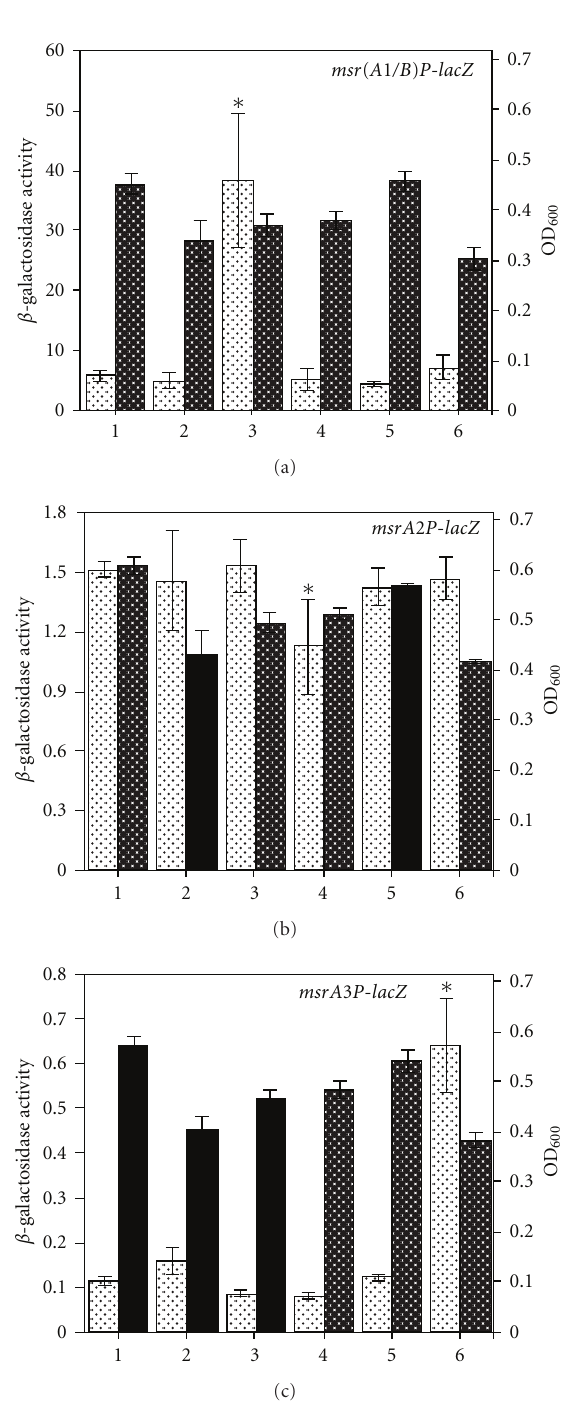
Figure 3: Expression of the msr(A1/B) , msrA2 , and msrA3 loci in S. aureus SH1000 under di ff erent environmental stress conditions. Cultures of S. aureus SH1000 msr(A1/B)P-lacZ , msrA2P-lacZ , and msrA3P-lacZ reporter strains were grown to OD 600 of 0.3 at 37 ◦ C and treated separately with H 2 O 2 (15mM) (2), oxacillin (1.2 μ g/mL) (3), pH 5.0 (4), pH 9.0 (5), and TSB with 1.5 M added NaCl (6) for 1h. β -galactosidase activity ( lighter bar ) and growth (OD 600 ) ( darker bar ) were subsequently determined. β - galactosidase activity and growth of cells in TSB control are represented in bars 1 . Values indicate averages of data from three independent experiments ± standard deviation